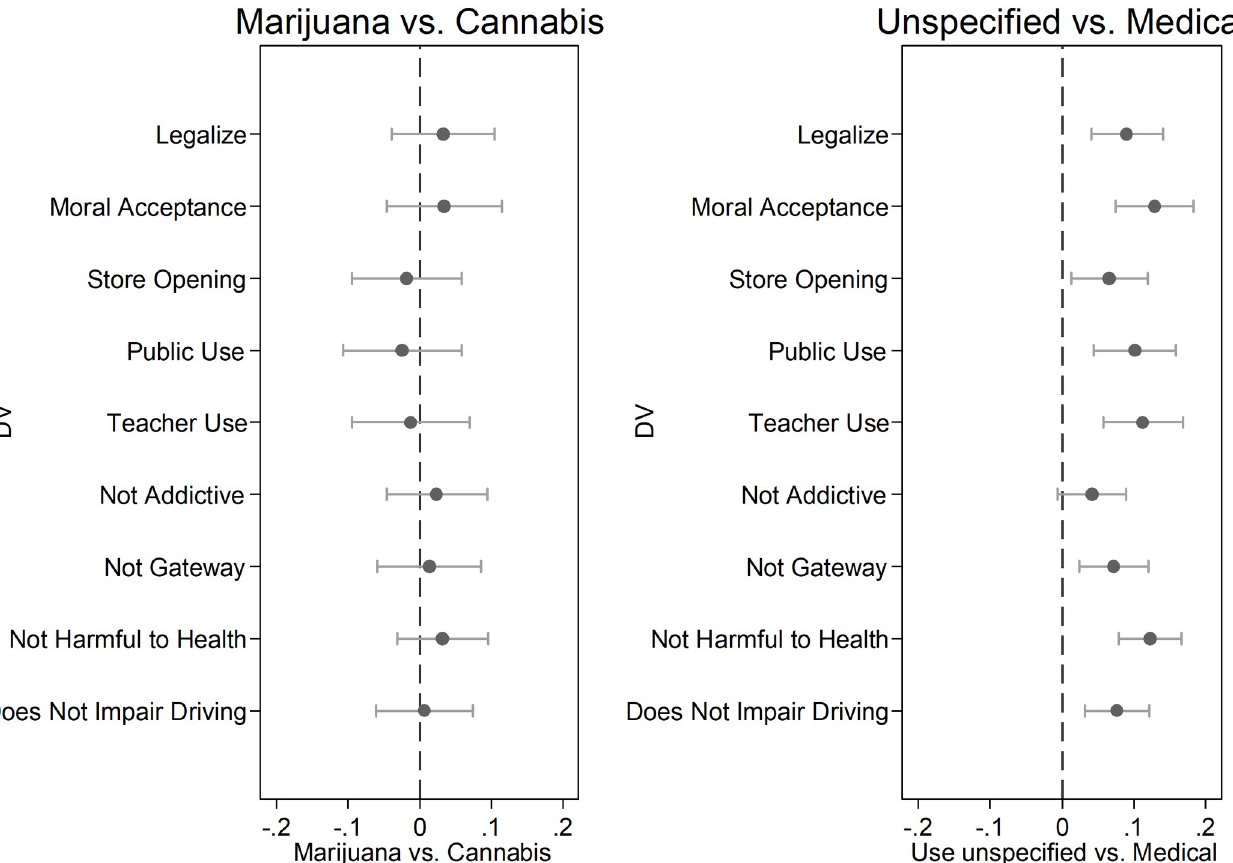
Fig 6. Summary of findings on policy and evaluations. OLS regression coefficients with 95% confidence intervals. Survey weights applied. Marijuana vs. Cannabis comparison reflects unspecified use. Unspecified vs. Medical comparison aggregates marijuana with cannabis in each use frame.